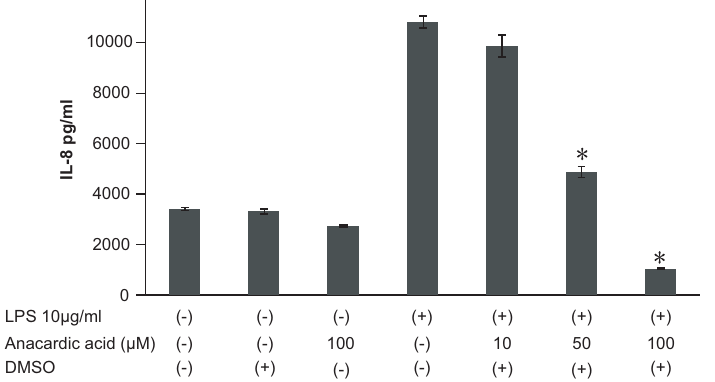
Figure 6. Effect of anacardic acid on lipopolysaccharide (LPS)-stimulated interleukin-8 (IL-8) release from A549 cells in vitro . Anacardic acid at 10 ~ 100μM treated 1 hr before LPS stimulation showed a significant inhibitory effect on LPS-induced IL-8 release. Data were expressed as mean±SEM. DMSO: dimethyl sulfoxide used for solvent. *P<0.05: compared to LPS (10μg/ml) stimulated cells (Mann- Whitney U test),